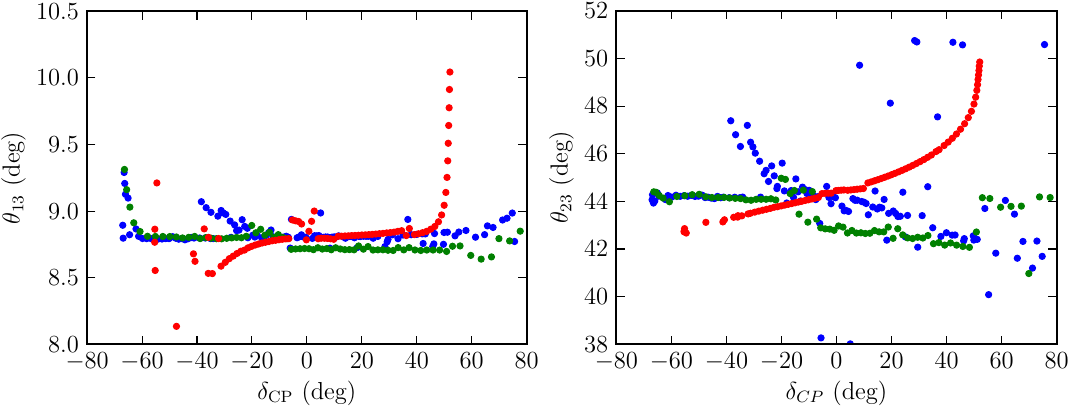
Figure 4 . Comparisons of the Dirac CP phase angle to neutrino mixing angles (cid:18) 13 ; 23 the model in the type-I seesaw case. Each color represents results for a di(cid:11)erent set of initial values for the input